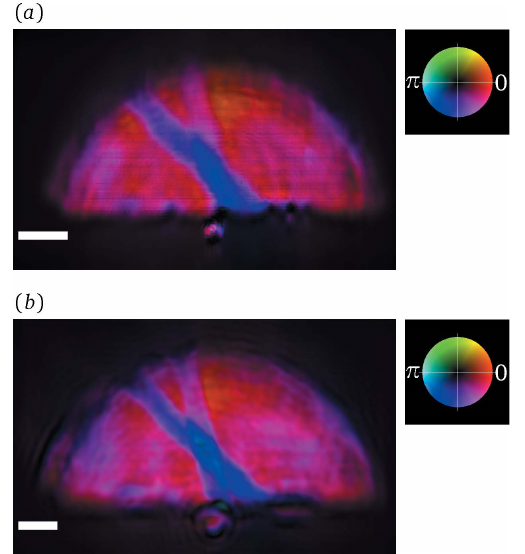
Figure 6 Grating-based imaging microscope with OSA. Panel ( a ) shows the retrieved wavefield in the sample plane of the imaging microscope with m T = 11/16. The analogous result from the projection microscope is shown in ( b ). There, the wavefield has been low-pass filtered in Fourier space using the expected diameter of the OSA. The phase shift following from the non-filtered reconstruction is depicted in Fig. 7( a ). For both panels, the scale bar indicates 10 m m length in the respective sample plane. Note that the sample magnification as well as the positioning of the carbon fibres within the field of view differ between both exposures.